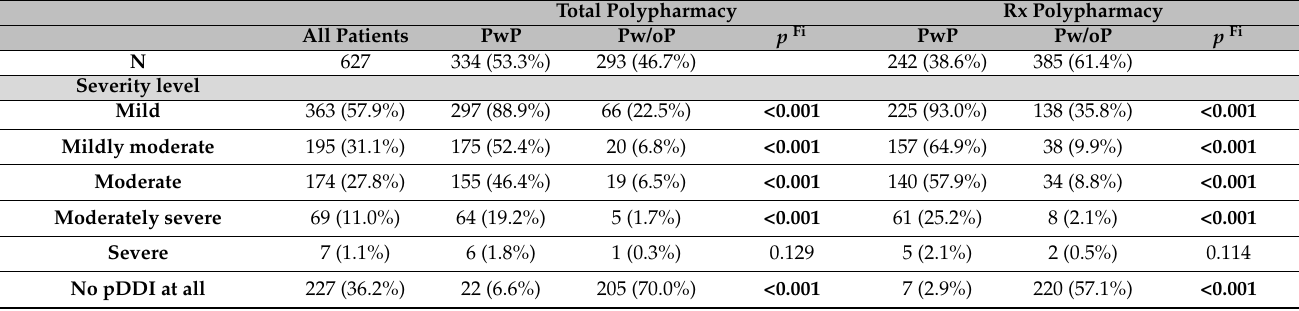
Figure 3. Proportion of patients with MS with at least one pDDI for each severity level and depending on the number of drugs used. The composite rating of pDDI severities was based on MediQ and Stockley’s drug interaction checker . Both prescription and over-the-counter drugs were considered for this plot. CI—confidence interval; MS—multiple sclerosis; pDDI—potential drug–drug interaction. Table 4. Prevalence of pDDIs in the patients with